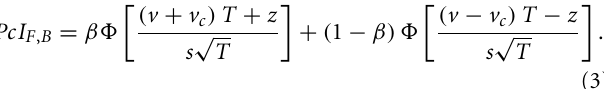
of the two response alternatives are equally difficult 2 . For fixed difficulty, the analytical expression for mean proportion